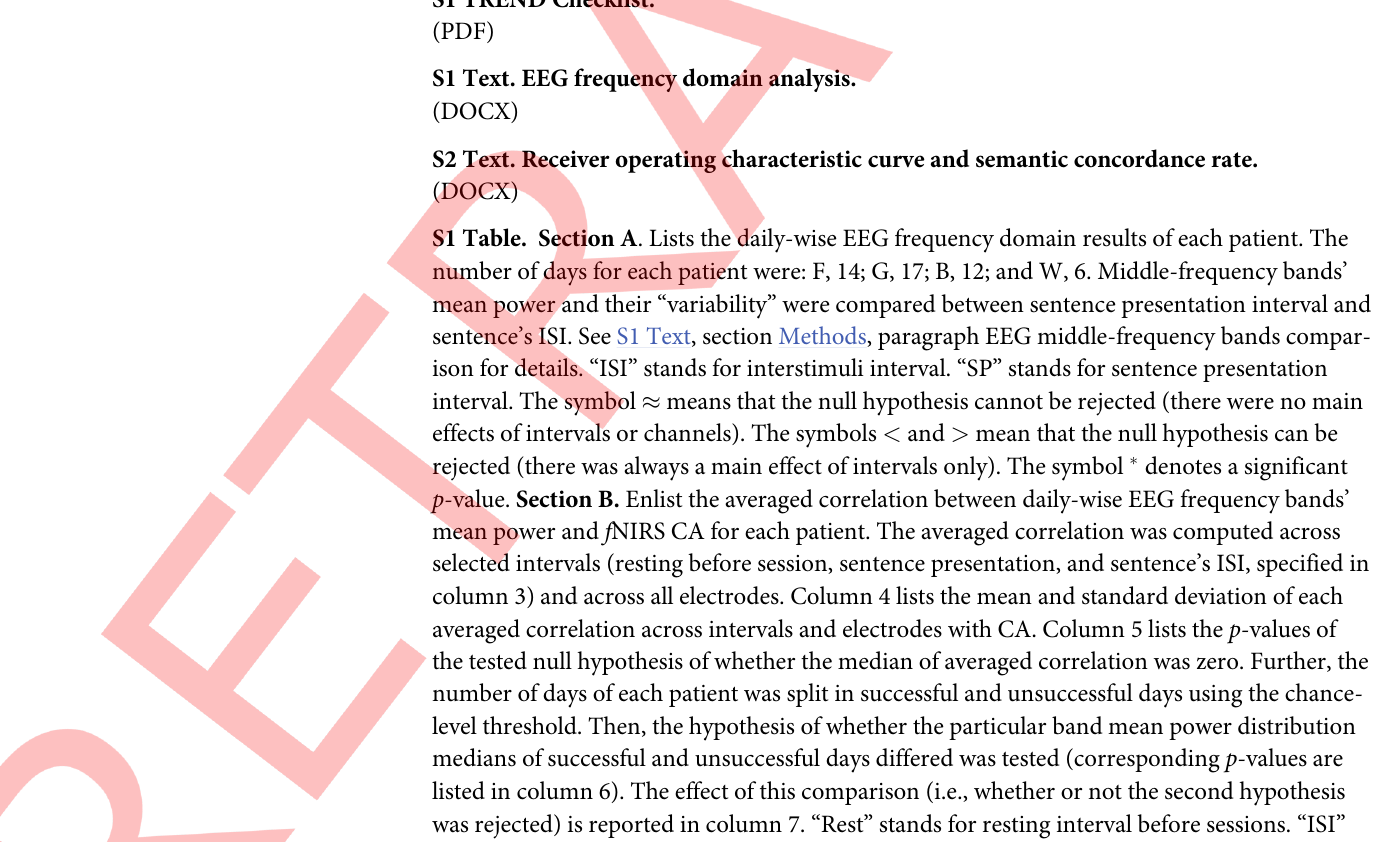
S1 Table. Section A . Lists the daily-wise EEG frequency domain results of each patient. The number of days for each patient were: F, 14; G, 17; B, 12; and W, 6. Middle-frequency bands’ mean power and their “variability” were compared between sentence presentation interval and sentence’s ISI. See S1 Text, section Methods, paragraph EEG middle-frequency bands compar- ison for details. “ISI” stands for interstimuli interval. “SP” stands for sentence presentation interval. The symbol (cid:25) means that the null hypothesis cannot be rejected (there were no main effects of intervals or channels). The symbols < and > mean that the null hypothesis can be rejected (there was always a main effect of intervals only). The symbol (cid:3) denotes a significant p -value. Section B. Enlist the averaged correlation between daily-wise EEG frequency bands’ mean power and f NIRS CA for each patient. The averaged correlation was computed across selected intervals (resting before session, sentence presentation, and sentence’s ISI, specified in column 3) and across all electrodes. Column 4 lists the mean and standard deviation of each averaged correlation across intervals and electrodes with CA. Column 5 lists the p -values of number of days of each patient was split in successful and unsuccessful days using the chance- medians of successful and unsuccessful days differed was tested (corresponding p -values are listed in column 6). The effect of this comparison (i.e., whether or not the second hypothesis was rejected) is reported in column 7. “Rest” stands for resting interval before sessions. “ISI” stands for interstimuli interval. “SP” stands for sentence presentation interval. “Succ.”